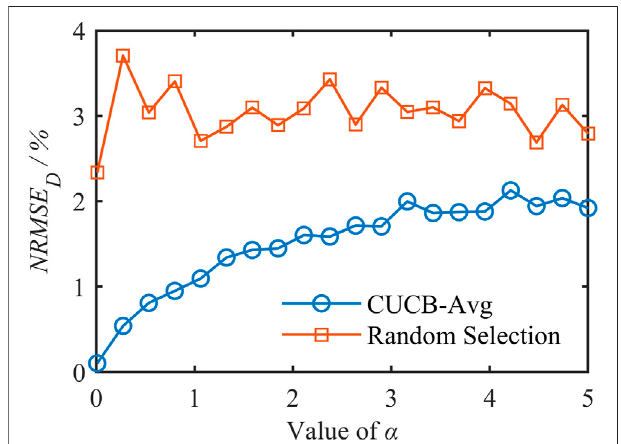
FIGURE 5 | The sum of variances corresponding to different α FIGURE 6 | NRMSE